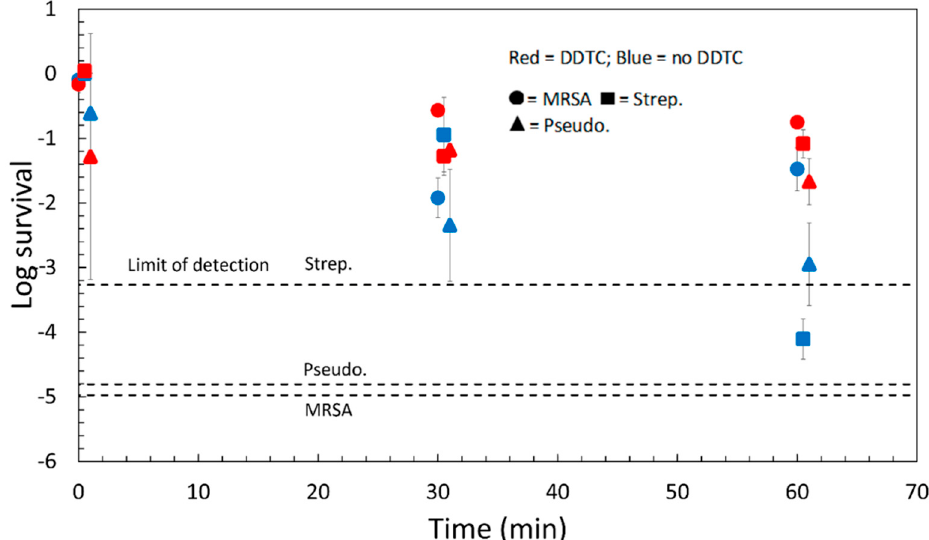
Figure 4. Time course of Survival on 2 µm Cu 2 O-treated polypropylene samples in the humidity chamber designed to reduce evaporation. Note that the vertical axis is on a log 10 scale. Results are shown with or without 6 mM diethyldithiocarbamic acid (DDTC). Data tabulated in Table S9. The MRSA and Step. data at zero time are all at about log survival = 0. The CFU reduction with time for each strain was lower in the humidity chamber than in the biosafety cabinet. Overall, CFUs were greater in the humidity chamber and in the presence of DDTC. Table 1. Comparison of Survival in an open container (Evap.) and humidity chamber (No Evap.). Organism Time